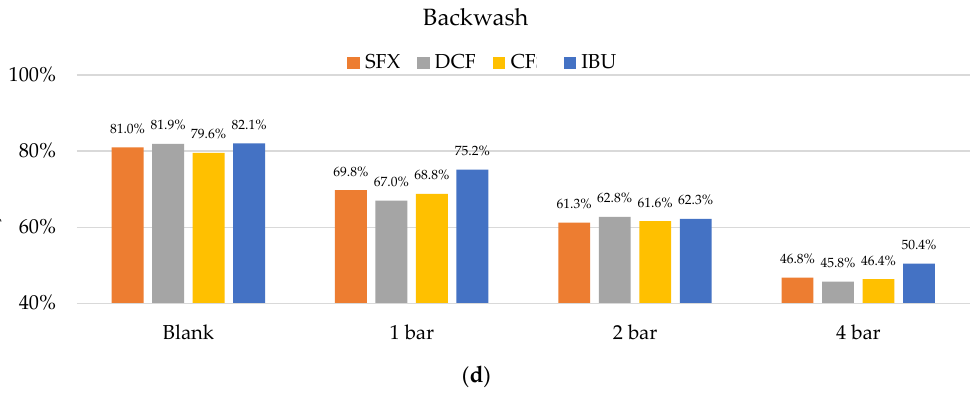
Figure 9. Rejection percentages of sulfamethoxazole (SMX), diclofenac (DCF), clofibric acid (CF), and ibuprofen (IBU): ( a ) Before cleaning (blank) and after cleaning with citric acid at pHs of 4, 3, and 2; ( b ) before (blank) and after cleaning with NaOH at pHs of 9, 10, and 11; ( c ) before and after cleaning with U53s of 0.1 to 10%; ( d ) and backwashes at different TMPs.